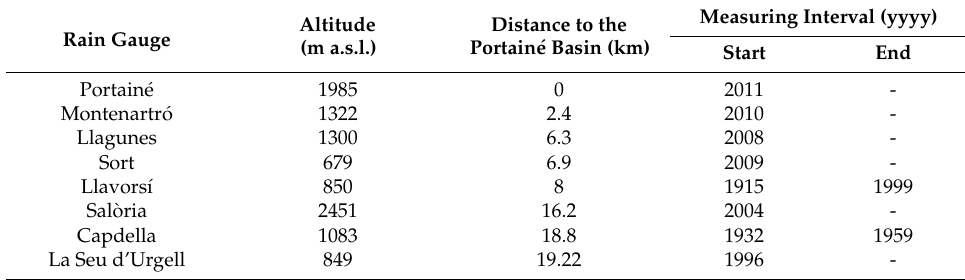
Table 1. Basic information on the rain gauges and data used in this study. Data used for long series construction (see Section 5.1.1) correspond to the stations highlighted in bold